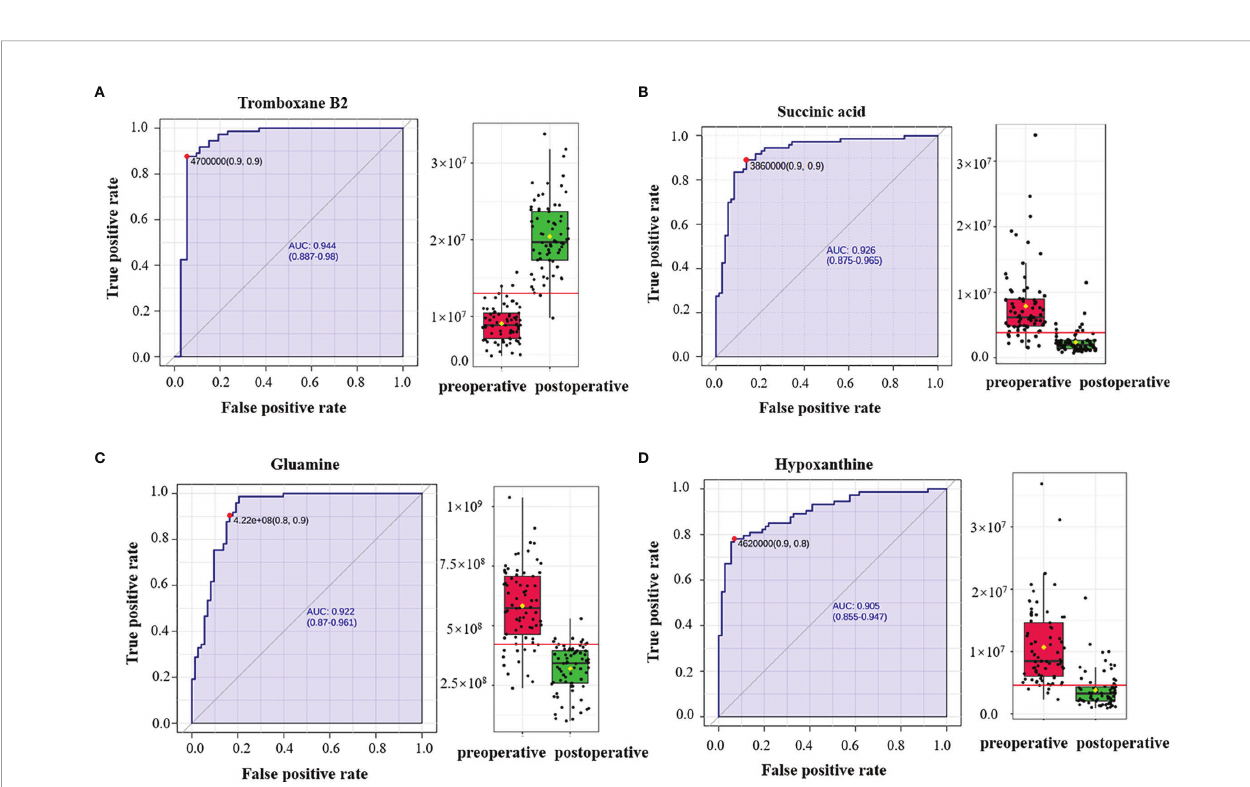
FIGURE 4 | Receiver operating characteristic (ROC) curves of plasma metabolites with area under the curve (AUC) values exceeding 0.9. ROC curves of (A) thromboxane B2, (B) succinic acid, (C) glutamine, and (D) hypoxanthine. The AUCs of thromboxane B2, succinic acid, glutamine, and hypoxanthine were 0.944 (95% CI = 0.887 – 0.98), 0.926 (95% CI = 0.875 – 0.965), 0.922 (95% CI = 0.87 – 0.961), and 0.905 (95% CI = 0.855 – 0.947), respectively. The box plots show the median, the quartiles, and the whole range of peak area of these